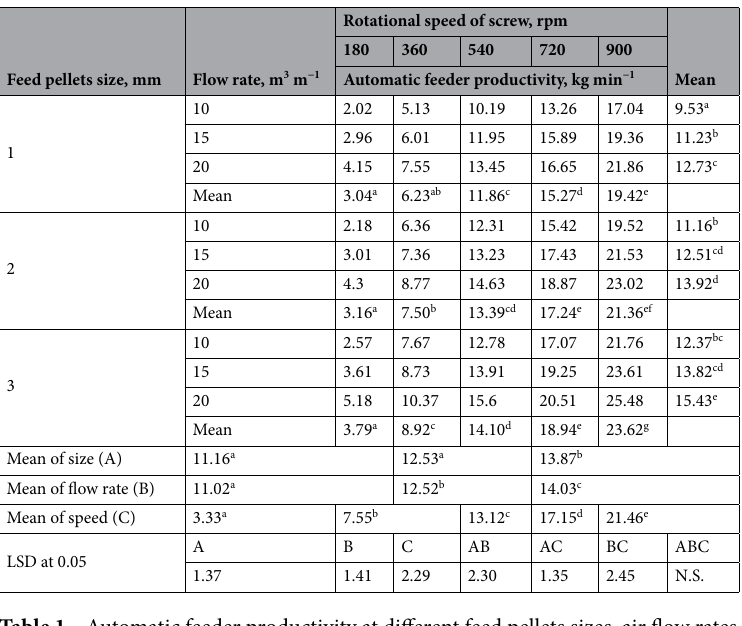
Table 1. Automatic feeder productivity at different feed pellets sizes, air flow rates and rotational speeds of screw. Superscripts letters mean significantly between the treatments (statistical analysis).